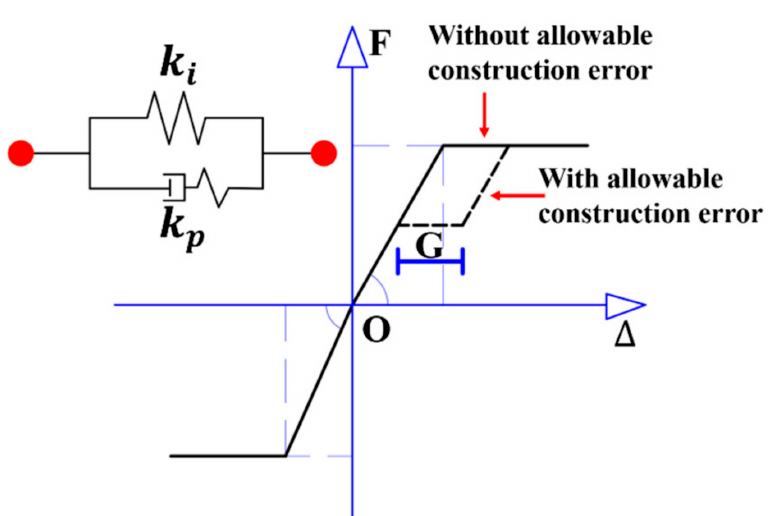
Figure 39. Spring model for understanding interaction mechanism between inbuild component and converged section